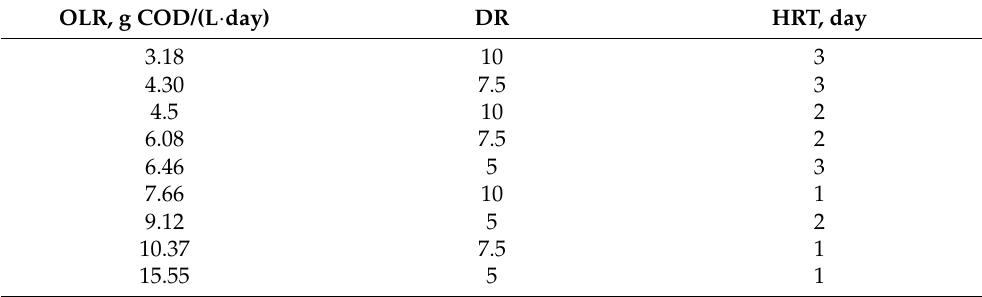
Table 2. OLR values depending on the DR and HRT.